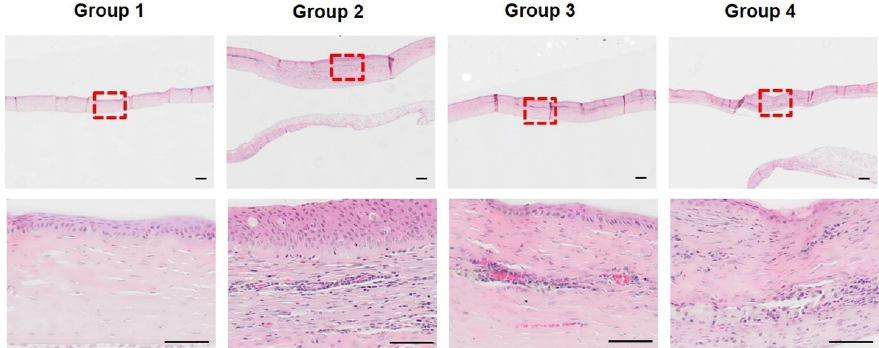
Figure 7. Immunohistochemistry of α -SMA of cornea as myofibroblast maker at three weeks after surgery was done. α -SMA positive cells were detected in brown. Few α -SMA was located focally below the basement membrane in group 1. α -SMA detection was remarkable in group 2 and 3. In group 4, α -SMA was hardly found. The area marked with a red square in the 20x magnification was observed at 200x magnification. Scale bar (black line) = 100 µm.